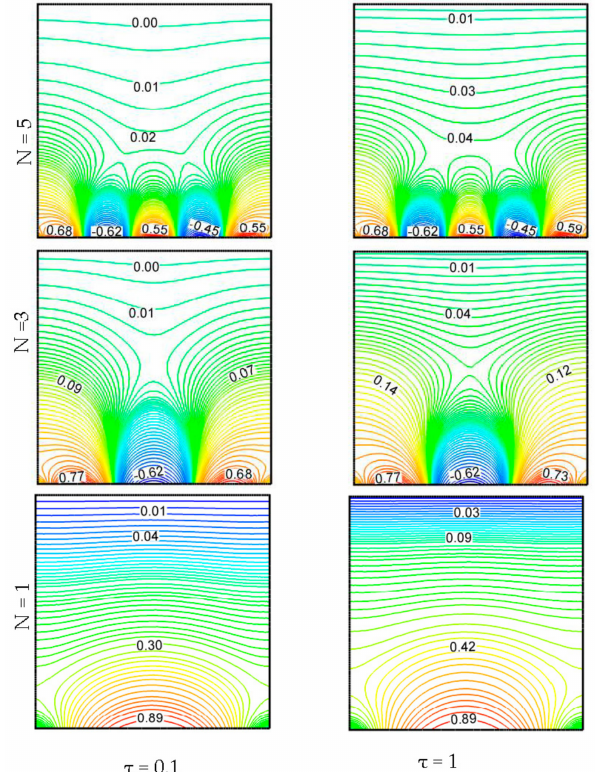
Figure 11. Influence of the odd values of N on isotherms for the selected values of τ with Gr = 10 6 .